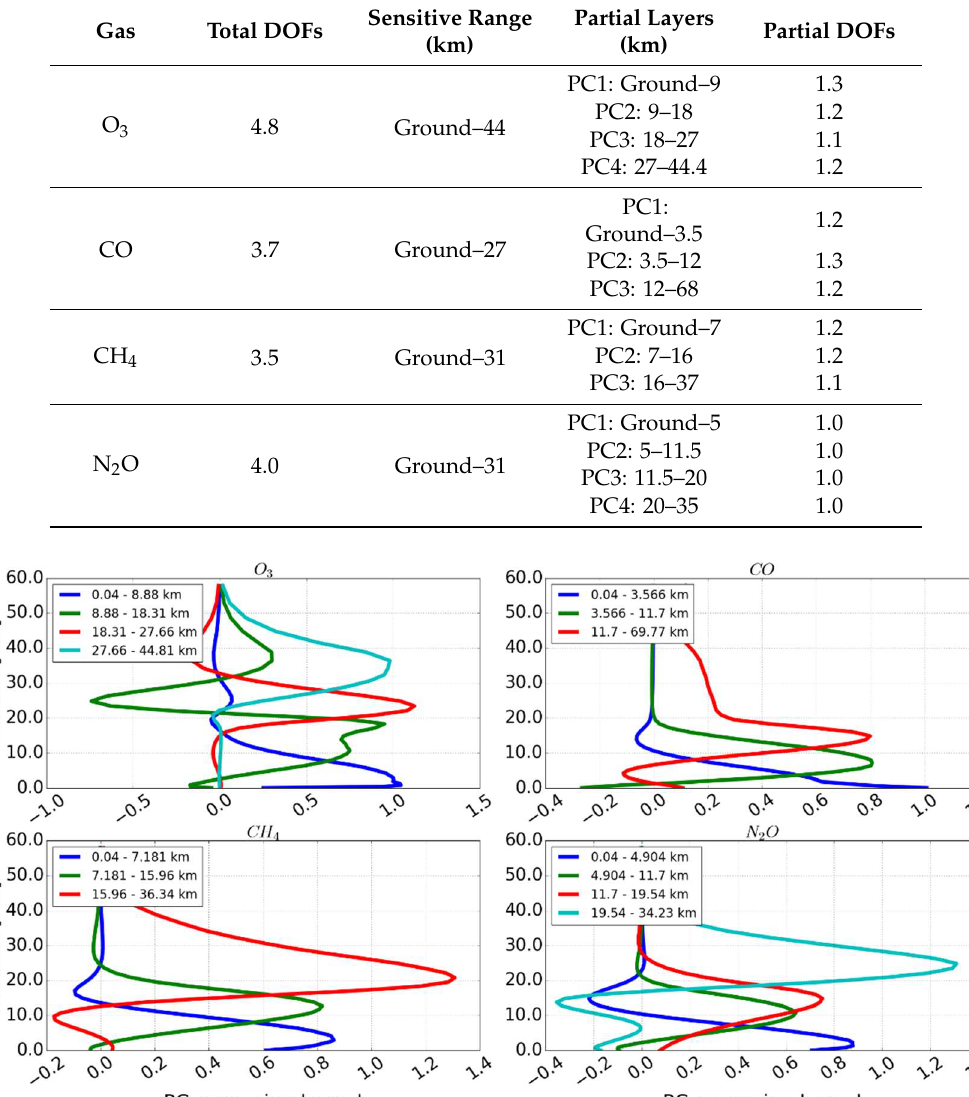
Figure 1. Partial column averaging kernels (PAVK) (ppmv/ppmv) for O 3 , CO, CH 4 , and N 2 O retrieval. Table 2. Typical degrees of freedom (DOFs) for the signal and sensitivity ranges of the retrieved O 3 , CO, CH 4 , and N 2 O profiles in Hefei, China.